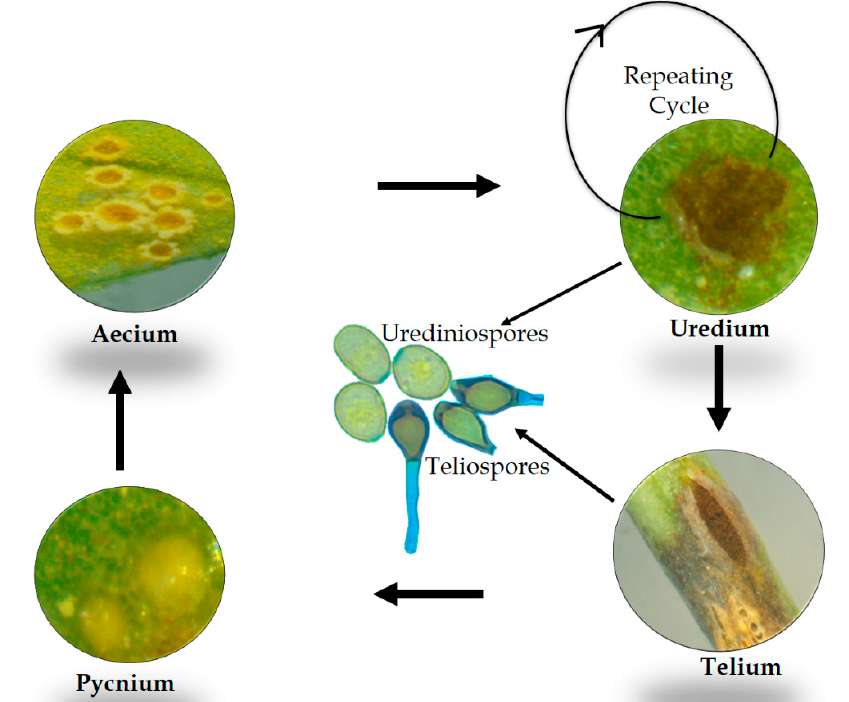
Figure 2. A general life cycle of rust genus Uromyces .